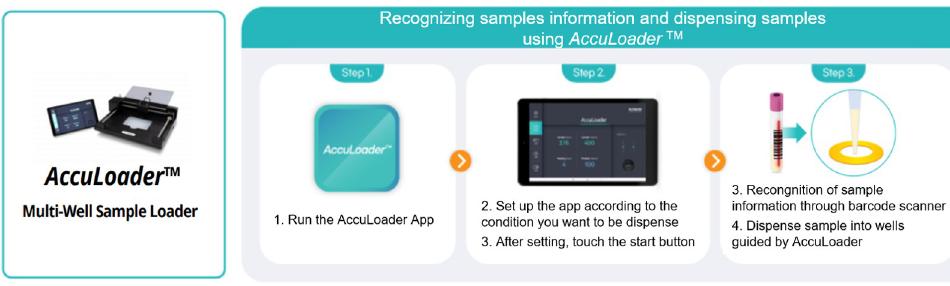
Fig 2. NPS/OPS specimens pooling with the AccuLoader ™ . AccuLoader ™ recognizes the information of each sample by scanning the barcode on a sample tube, then guides the user to dispense samples in the correct well.